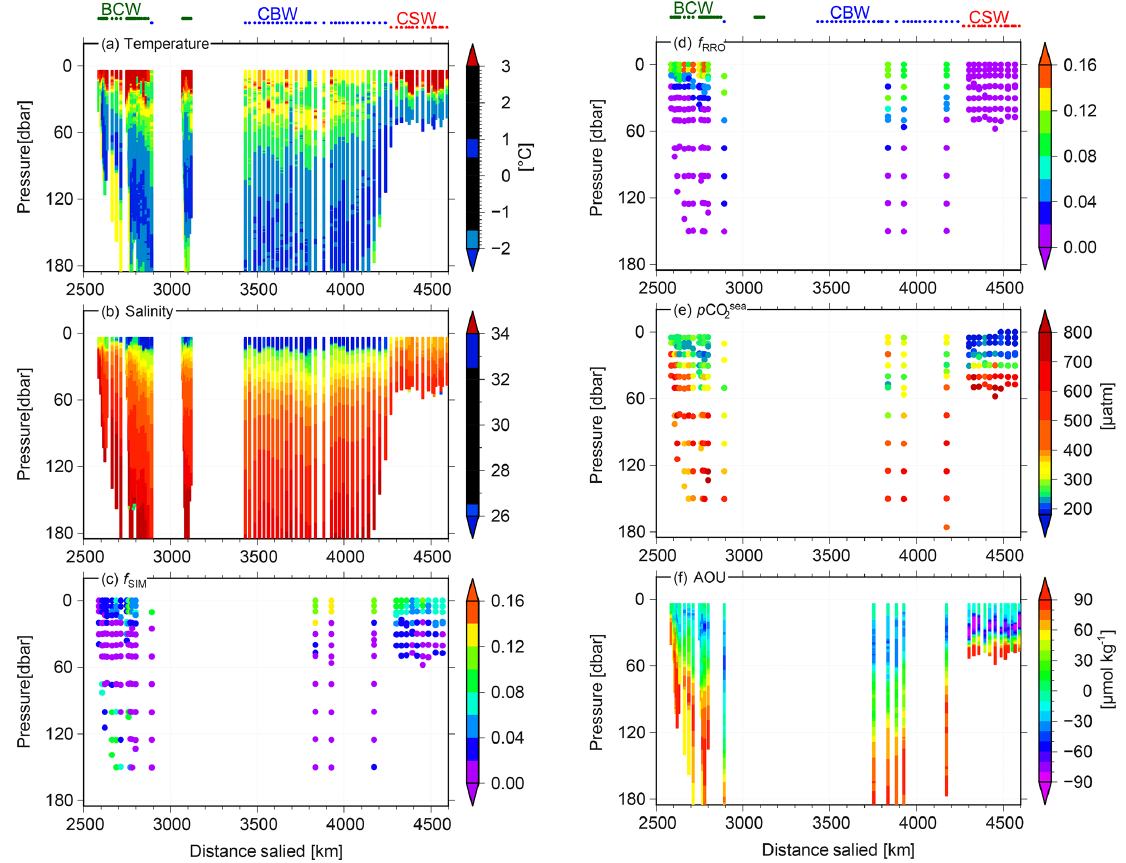
Figure 5. Water-column profiles of (a) temperature, (b) salinity, (c) f SIM , (d) f RRO , (e) p CO sea along the cruise track in the period 4–11 September 2013. Data were obtained by CTD and XCTD in (a) and (b) , by oxygen sensor SBE43 on CTD in (f) and by discrete bottle samples in (c) , (d) , and (e) . Water types BCW (Barrow coastal water), CBW (Canada Basin water), and CSW (Chukchi Sea water) are indicated at the top of the